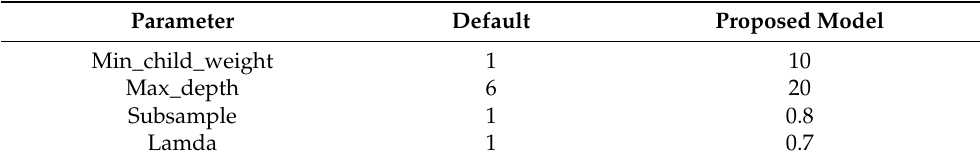
Table 2. Important default values and tuned parameter settings of the proposed model.